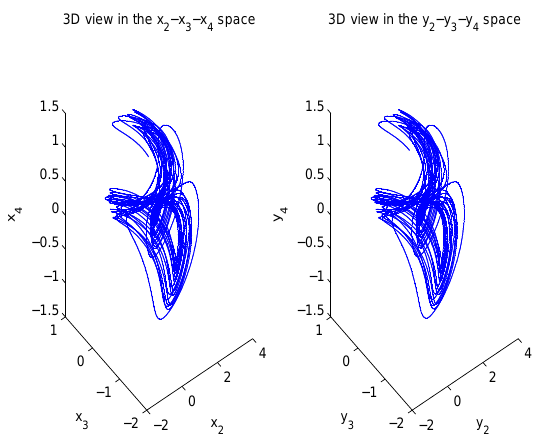
Figure 2. Three-dimensional view synchronization for fractional-order